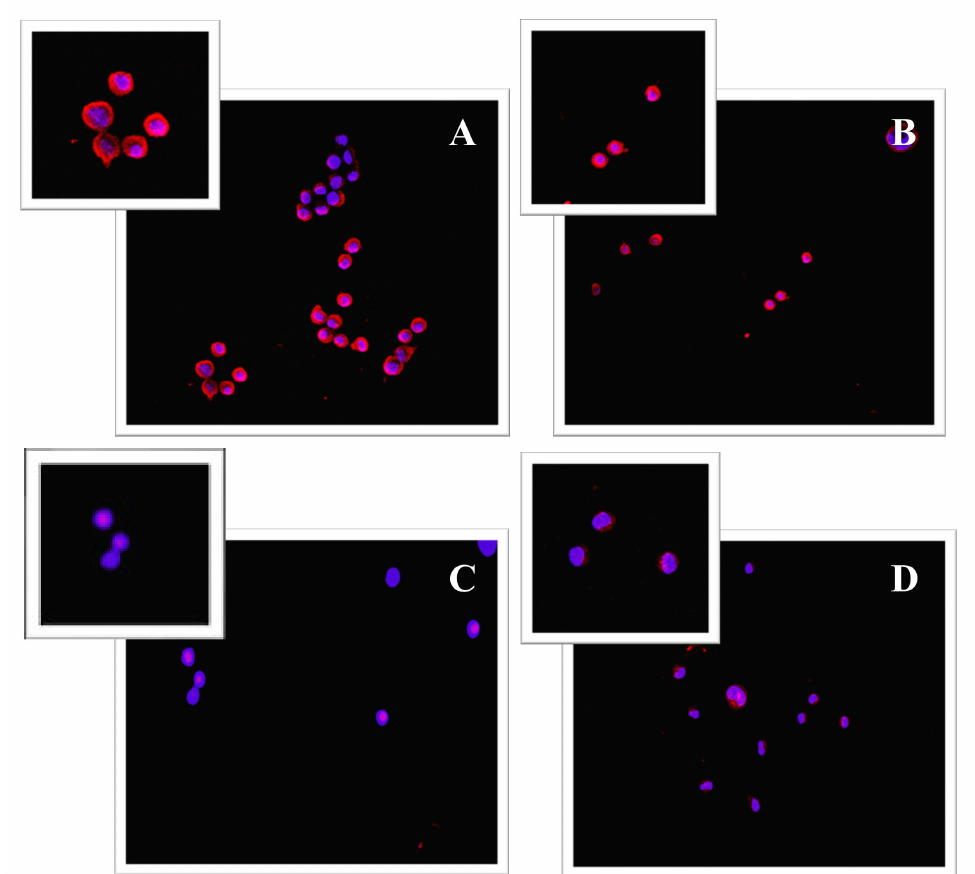
Figure 6. Panel of immunofluorescence staining for β -catenin (red fluorescence). β -catenin fluores- cence pattern in control cells, MM.1S ( A ), and MM.1R ( B ) is mainly distributed at the perinuclear and plasma membrane level, as clearly shown in the magnifications in the left corners; MM.1 S cells treated with BCP for 24 h showed a strong reduction in β -catenin staining ( C ); BCP treatment for 24 h caused a significant β -catenin fluorescence reduction in MM.1R treated cells ( D